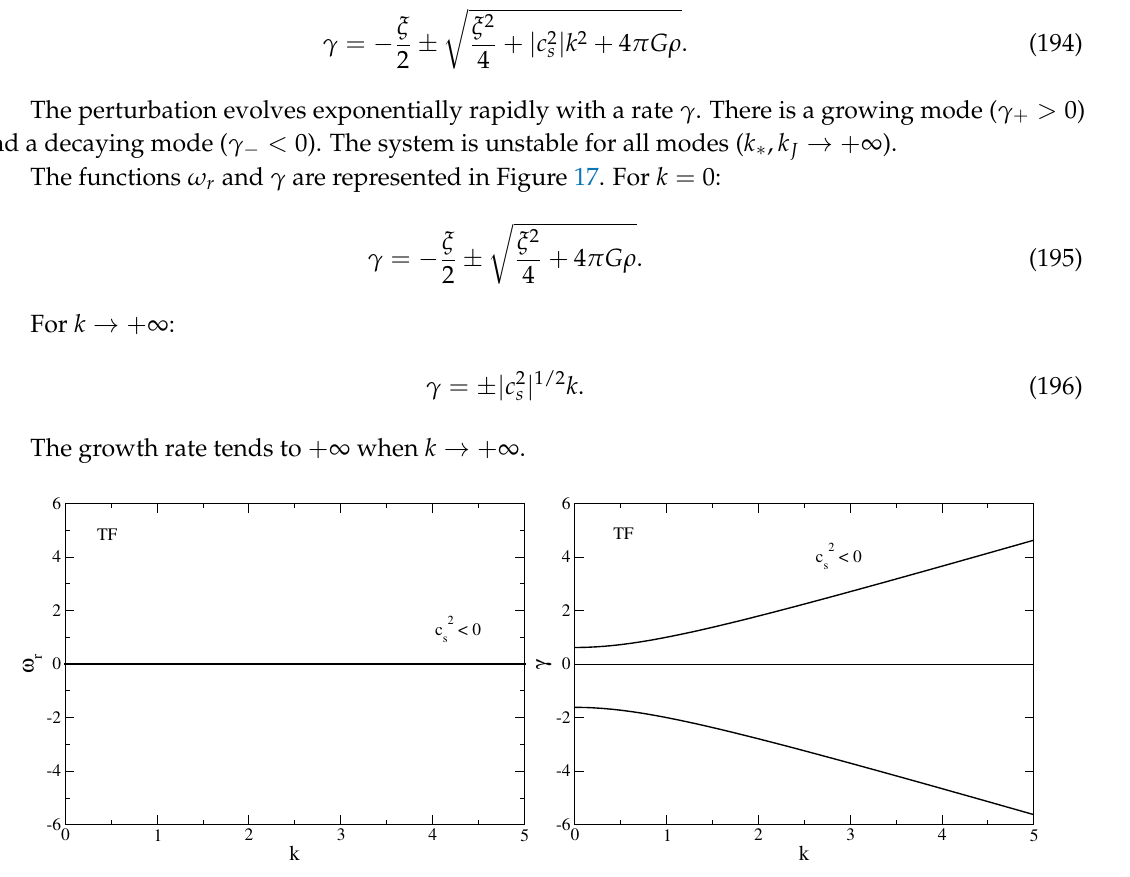
Figure 17. Dispersion relation for self-gravitating BECs in the TF limit (¯ h = 0) when c 2 s < 0. We have normalized the wavenumber by ( 4 π G ρ / | c 2 s | ) 1/2 and the pulsation and the friction by ( 4 π G ρ ) 1/2 . This is equivalent to taking 4 π G = ρ = m = | c 2 s | = 1 in the dimensional equations. We have selected ξ =